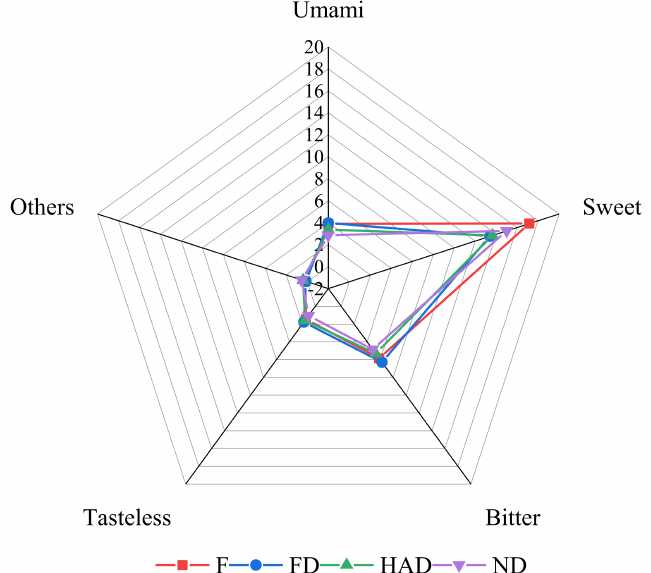
Figure 3. Radar graph of the sensory results of fresh and different dried L. edodes ; F: fresh sample;